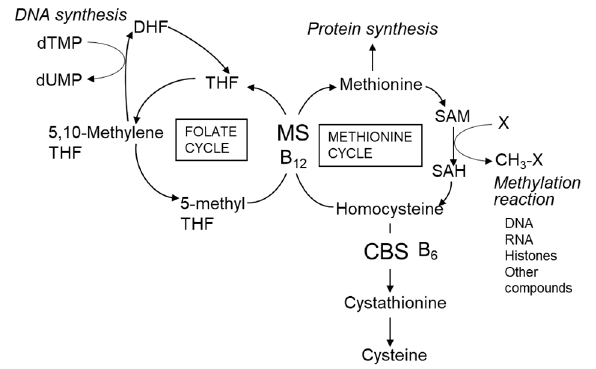
Figure 2. Homocysteine metabolic pathway in mammals. Abbreviations: B 6 , vitamin B 6 ; B 12 , vitamin B 12 ; CBS, cystathionine β -synthetase; DHF, dihydrofolate; MS, cobalamin-dependent methionine synthase; SAM, S-adenosyl methionine; SAH, S-adenosyl homocysteine; THF, tetrahydrofolate.